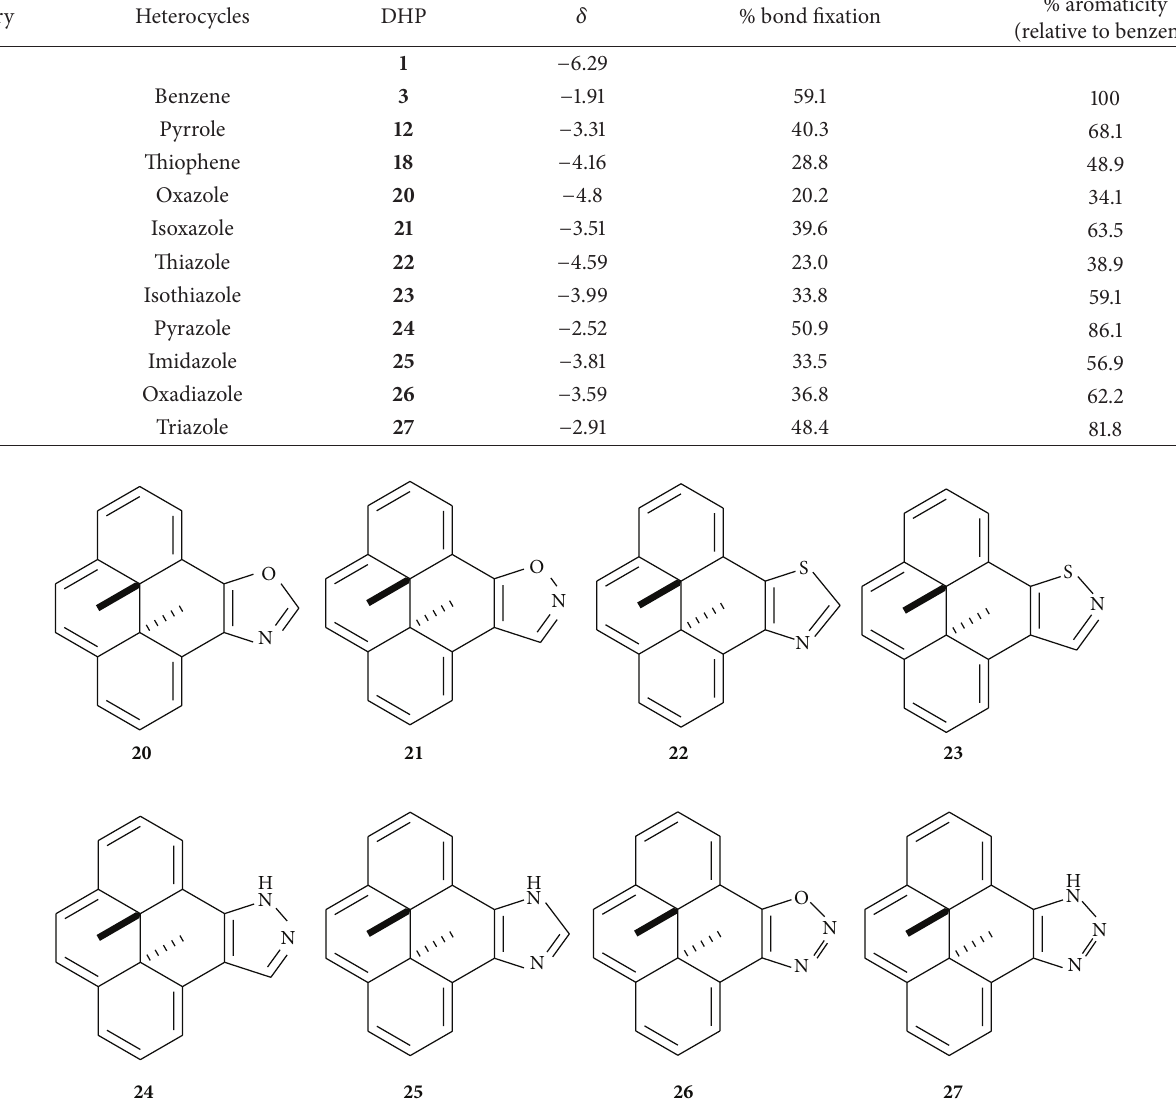
Table 1: Comparison of 1 H NMR chemical shifts (calculated), % bond fixation of dihydropyrene nucleus, and % aromaticities of five membered heterocycles with benzene, calculated through (2).